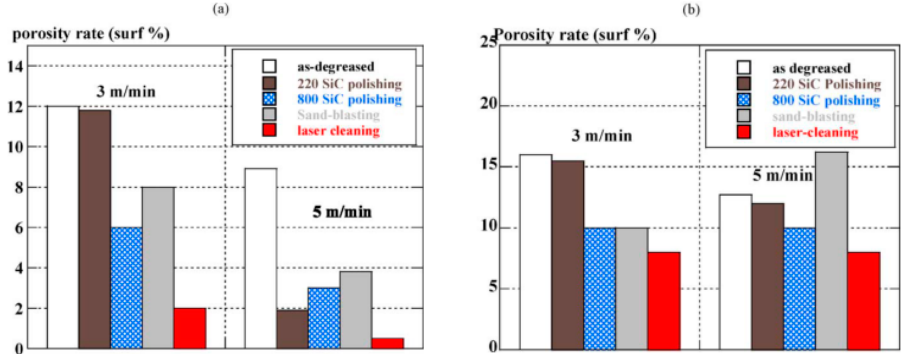
Figure 8. Influence of surface preparation on the porosity rate with two different welding speeds at 4 kW in ( a ) A356 and ( b ) AA5083